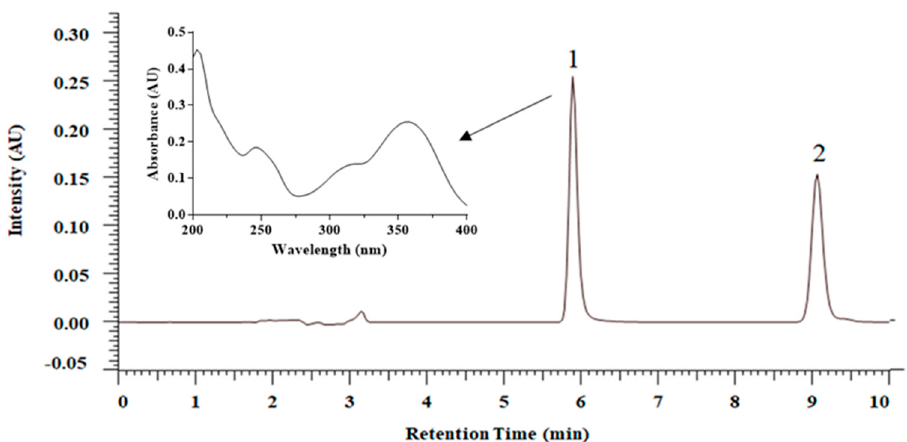
Figure 2. HPLC–DAD chromatogram and UV spectrum of fisetin (25.0 µ g/mL) and luteolin (as internal standard) (25.0 µ g/mL): 1. fisetin; 2. luteolin.